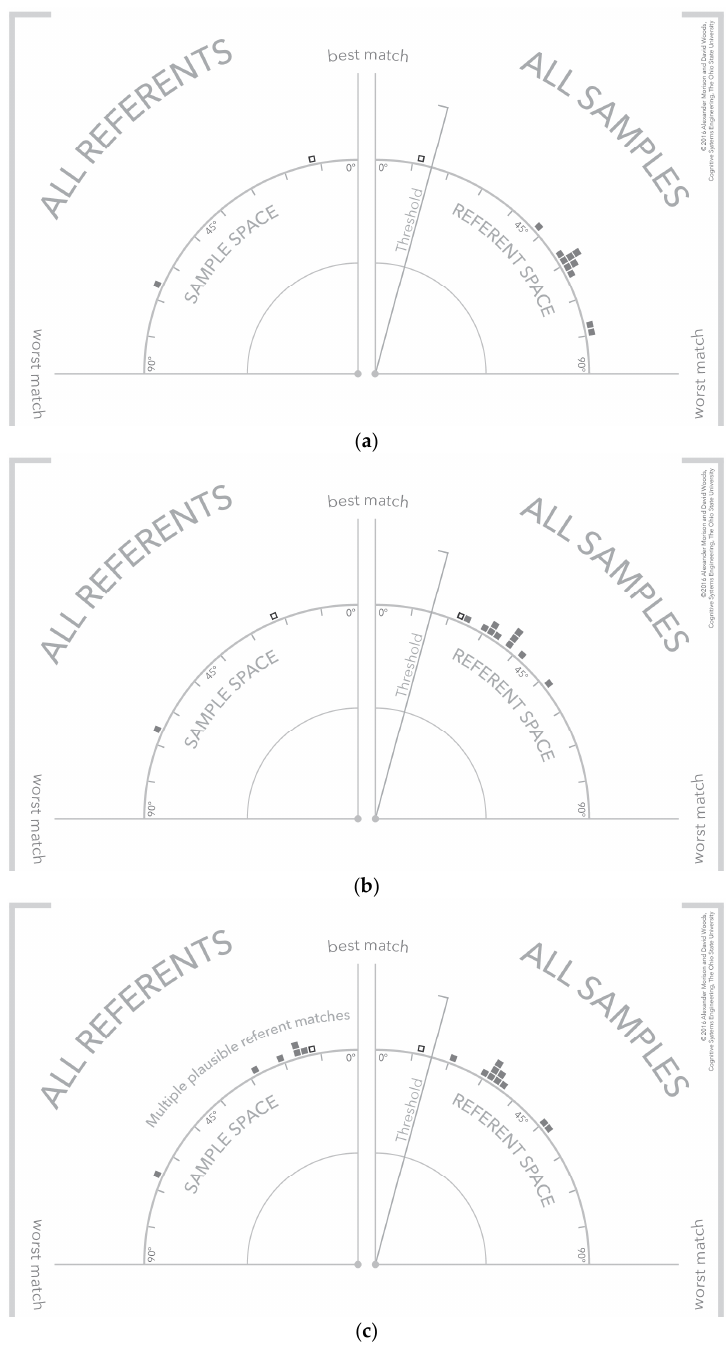
Figure 8. The visualization demonstrating three different types of samples: ( a ) a strong signal referent match; ( b ) no signal detection; and ( c ) a signal detection with multiple potential referent matches.